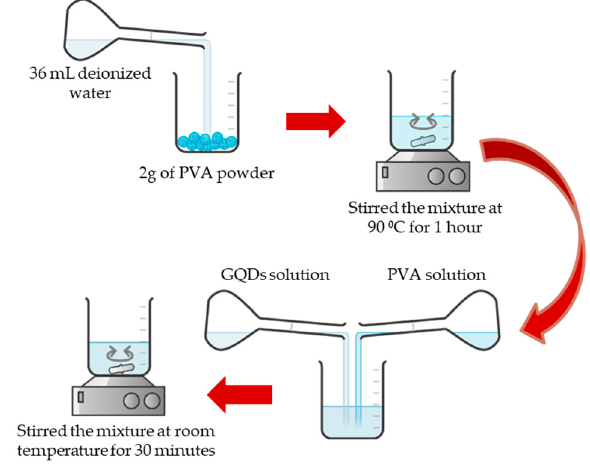
Figure 1. The schematic preparation of the composite solution.